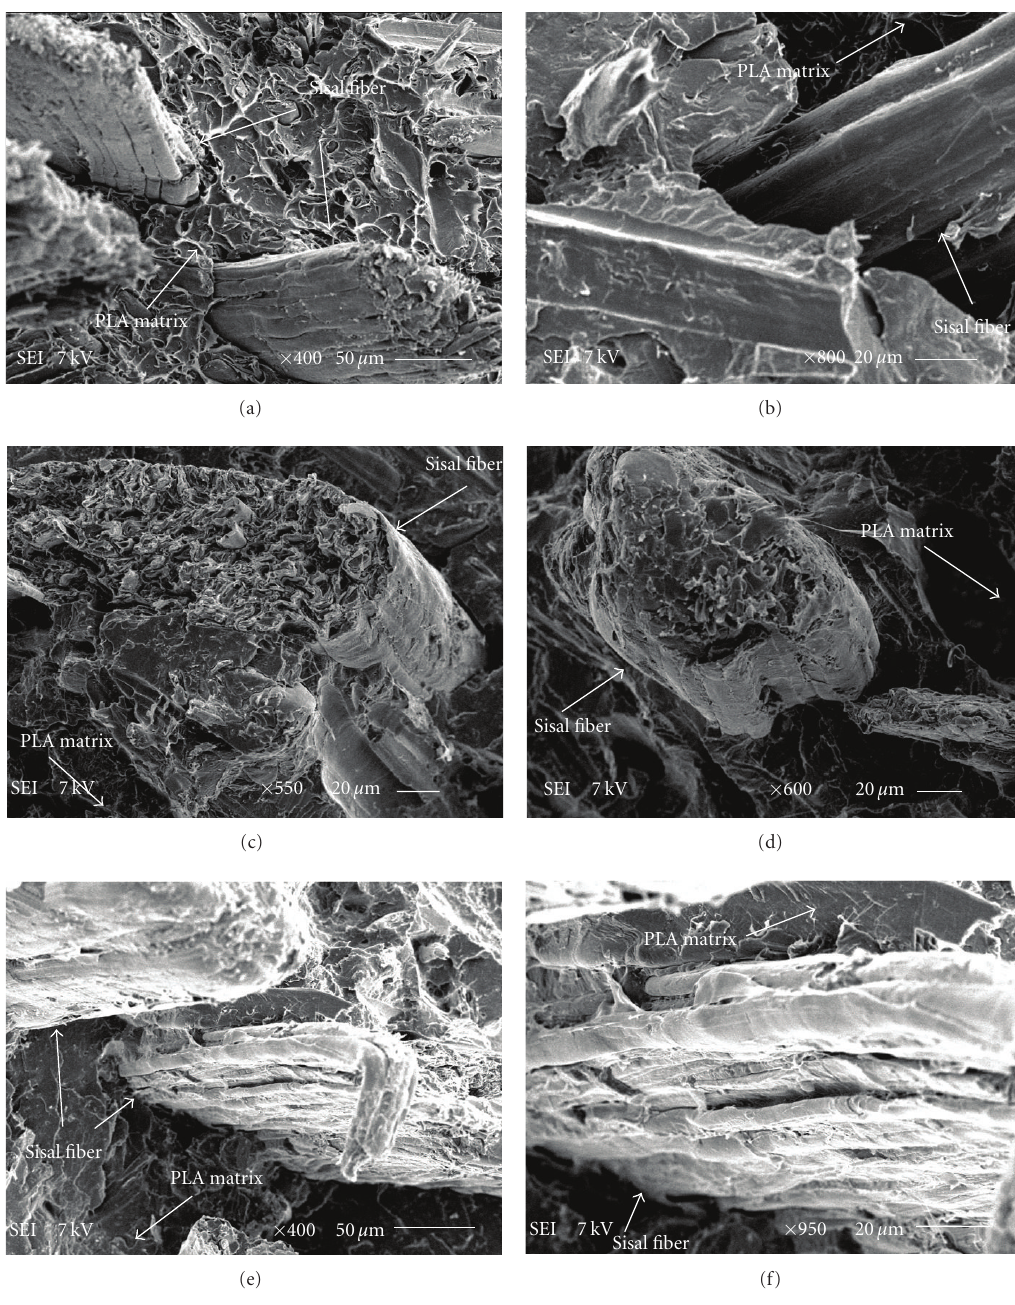
Figure 8: Morphology of a fractured surface of 30 wt.% sisal fiber/PLA composites. (a, b) Unmodified sisal fiber; (c, d) sisal fiber modified with PLA-co-PGMA; (e, f) sisal fiber modified with MPS-g-PLA.